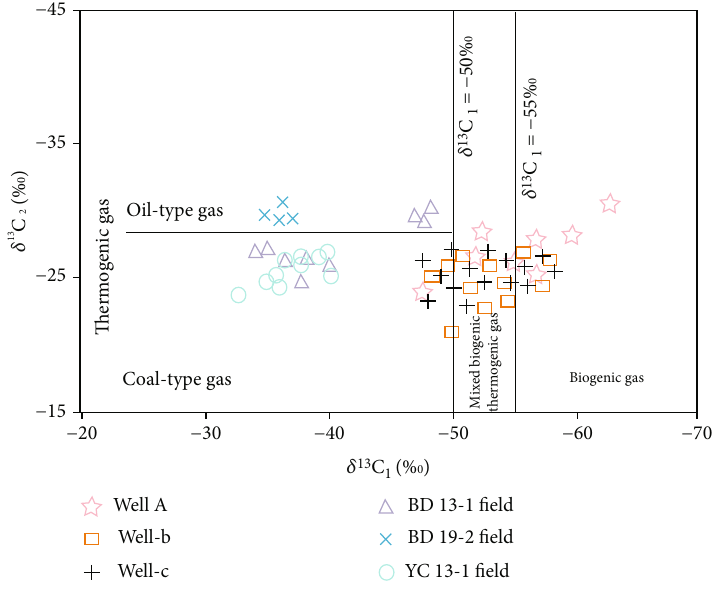
δ 13 C Figure 11: Cross-plot of δ 13 C 1 and 2 values for the gas samples collected from the QDNB (the BD19-2 gas fi elds are cited from [28], the δ 13 C values of natural gas from YC13-1 is cited from [41], the δ 13 C values of natural gas from well- b, well-c are cited from